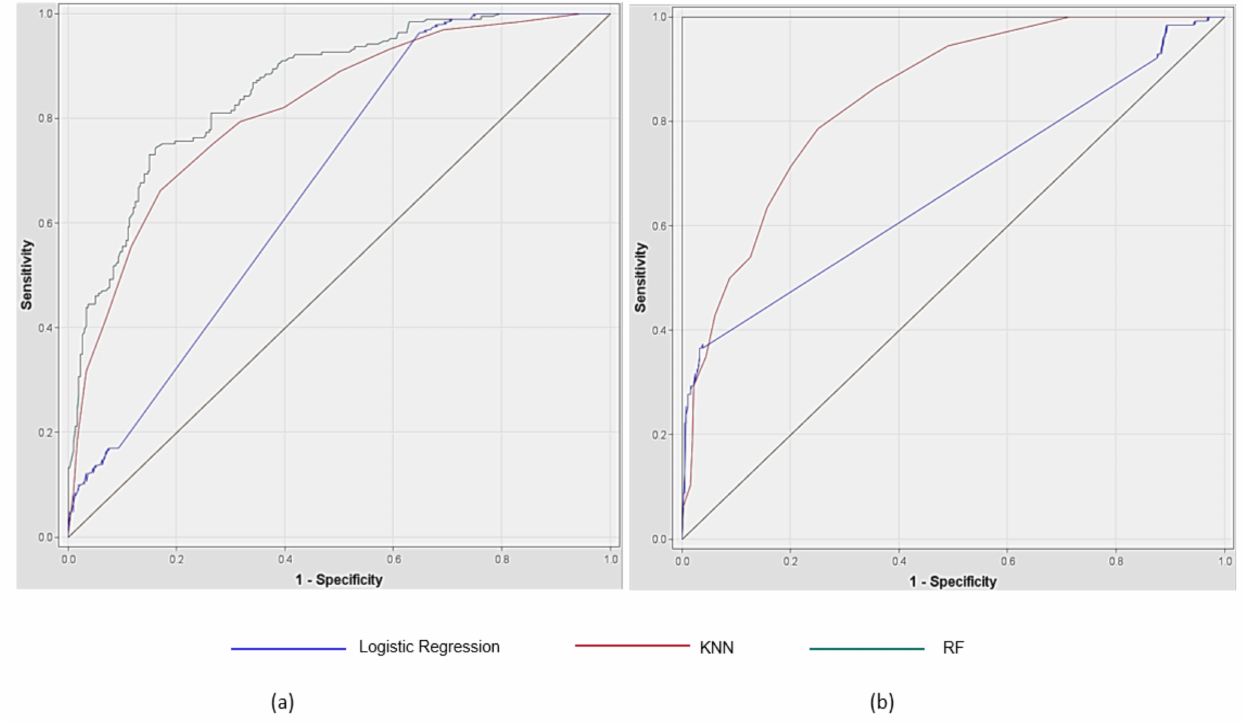
Figure 4. ROC Curves of depression and suicidal risk prediction; ( a ) Depression; ( b )